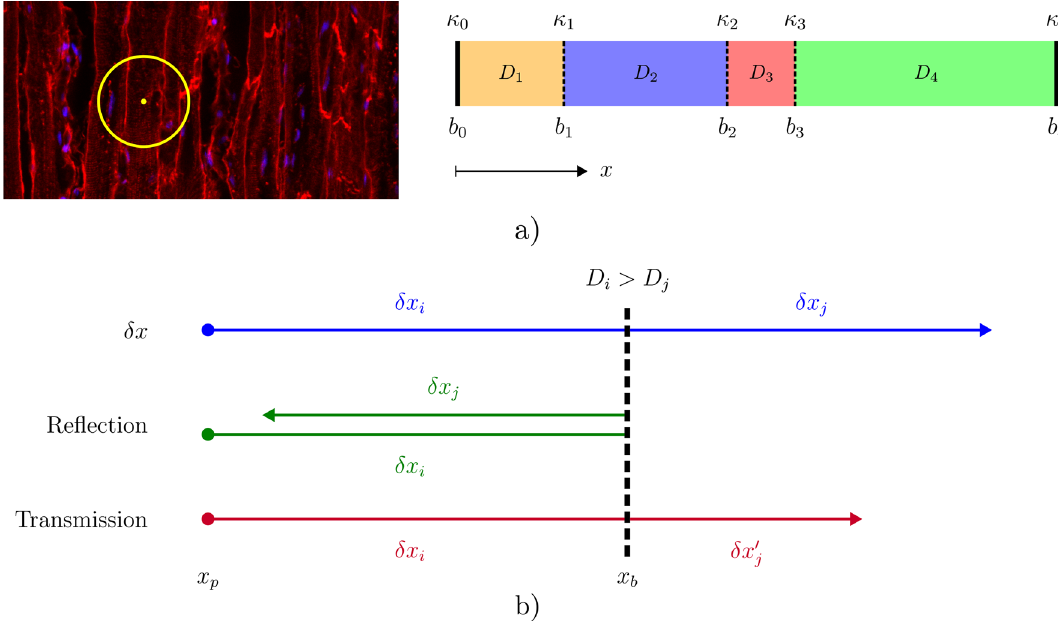
Figure 1. ( a ) Left: Confocal fluorescence microscopy image of cardiomyocytes running vertically. The mean 30 µ m over 100 ms is indicated as the radius of the yellow circle. Right: Schematic diffusion distance (cid:31) x ≈ 4 compartments with indices i . Each compartment has two barriers with of an example domain with m = b i b j with permeabilities κ i and κ j . Note that the domain b i , x b their corresponding locations x b 1 = = = + 0 ). ( b ) Illustration of the behaviour of a single κ m ends enforce the zero-flux boundary conditions ( κ 0 = = walker at x p performing a random step δ x towards a barrier at x b . Initially, the step is divided into δ x i and δ x j . δ x i δ x j ) or enters the x p Depending on the transit decision, the walker is either reflected elastically ( x = + − new compartment with D j < D i . In the latter case, the remaining step after transit is modified to δ x ′ j to preserve δ x ′ < δ x j a constant net step size. Note that when entering a region of lower diffusion coefficient (and j | | | | conversely for D j < D i